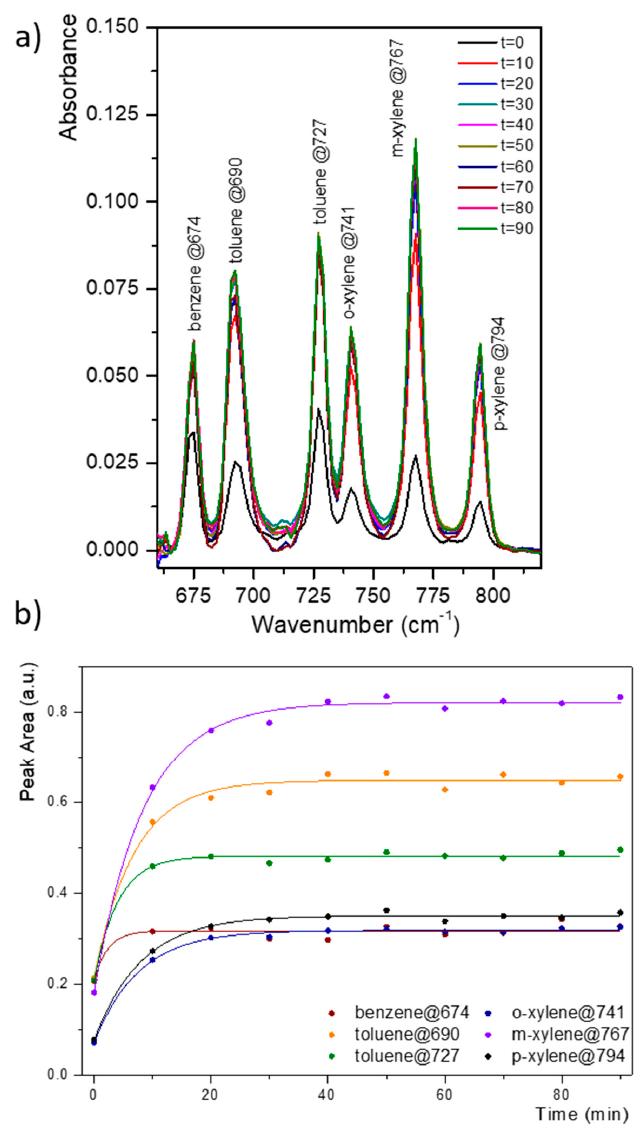
Figure 6. MIR-ATR absorption spectra of the BTX mixture (benzene, toluene, ortho-, meta-, and para-xylenes) at 5 ppm concentration obtained with PIB coated on a Ge 28 Sb 12 Se 60 planar waveguide deposited on a ZnSe prism with a thickness of 2.5 µm ( a )—Enrichment curves for the 5 ppm BTX (benzene, toluene, ortho-, meta- and para-xylenes) mixture obtained with a PIB coating on a chalcogenide thin film Ge 28 Sb 12 Se 60 (t = 2.5 µm) on a ZnSe prism ( b ).